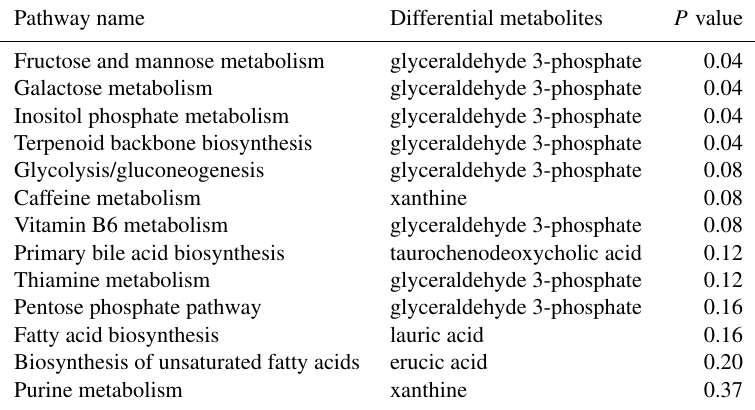
Table 3. Annotation of differential metabolites between the agomiR-499-treated group and the control.